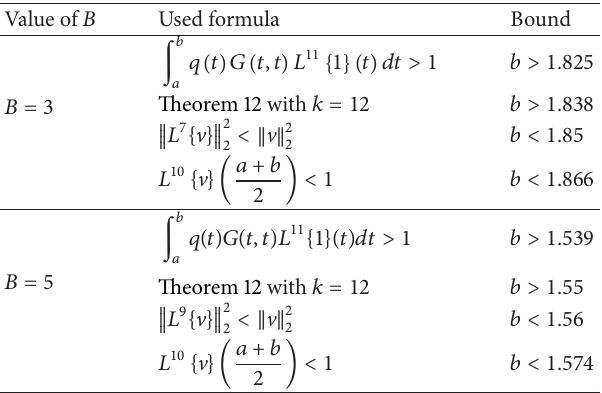
Table 5: Comparison of bounds for 𝑏 in Example